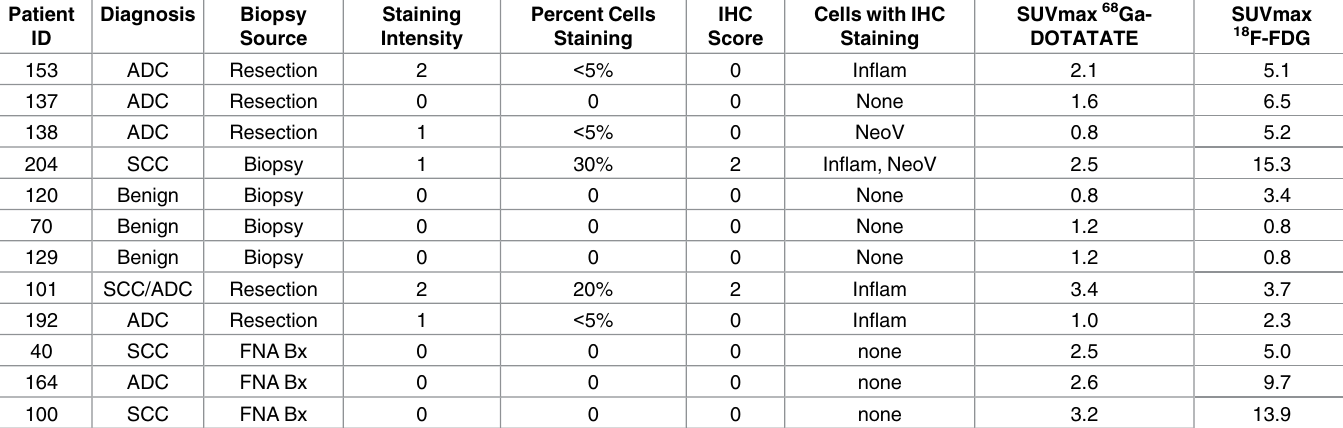
Table 4. SSTR2 IHC staining results—12